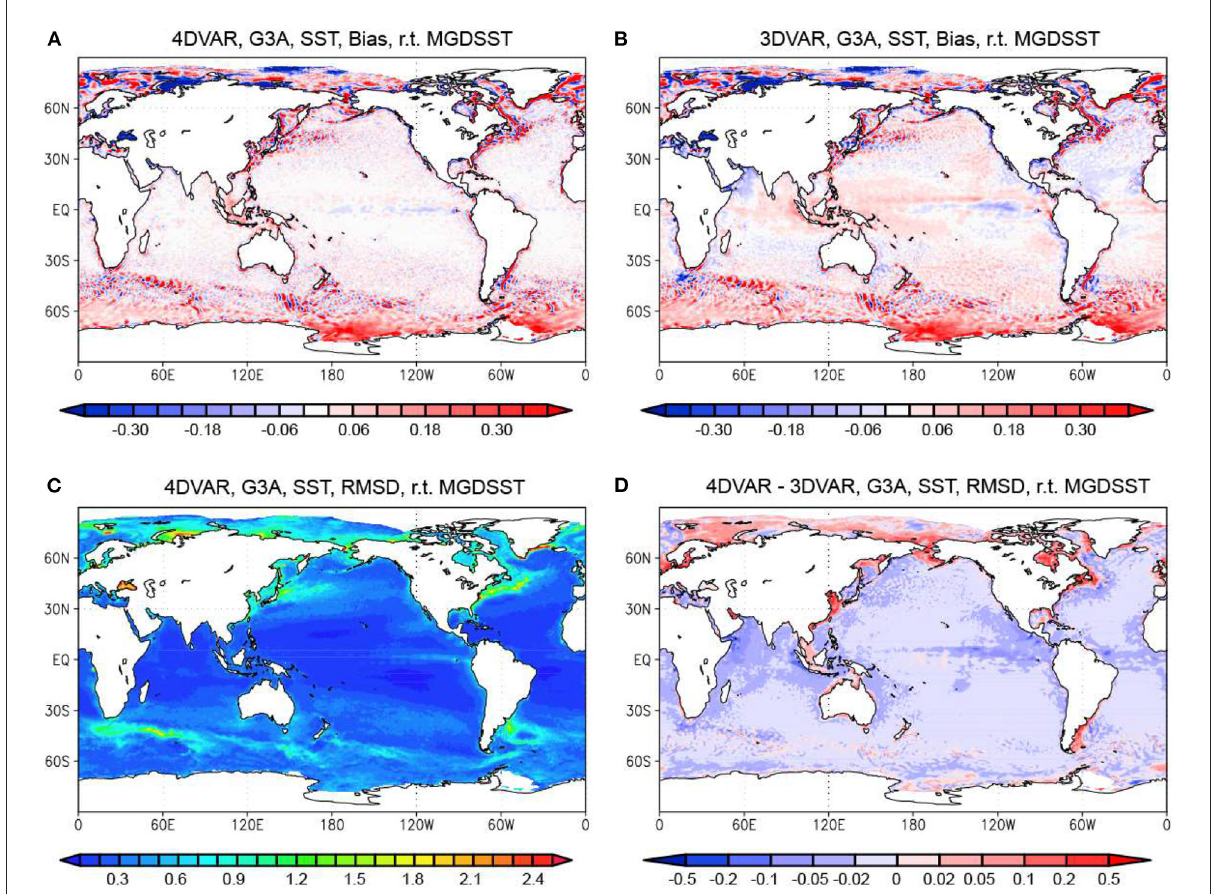
FIGURE2 Bias and RMSD of the MOVE-G3A SST for the 4DVAR and 3DVAR Runs relative to MGDSST. (A) Bias in the 4DVAR Run. (B) Bias in the 3DVAR Run. (C) RMSD in the 4DVAR Run. (D) Difference of the RMSDs between the 4DVAR and the 3DVAR Runs. Blue colors in (D) mean that the RMSD is smaller for the 4DVAR Run. Units in ◦